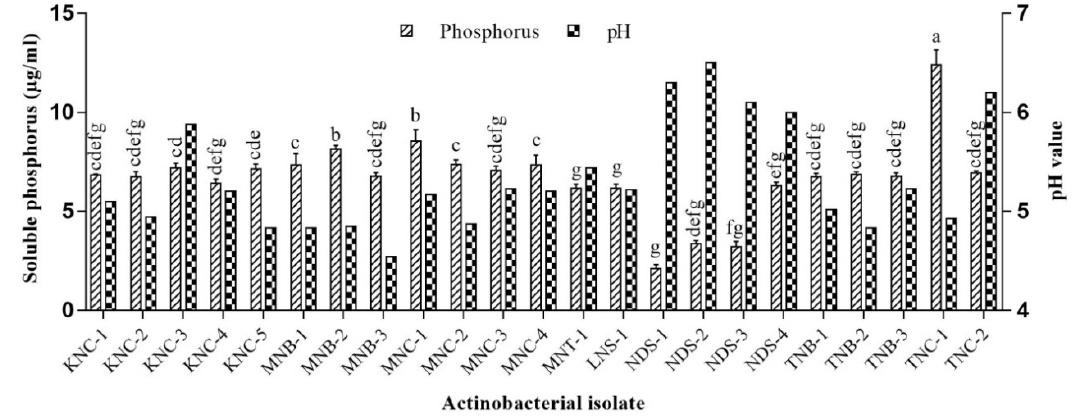
Figure 2. Determination of P solubilization and the evolution of pH in the culture supernatant of actinobacterial isolates. Means ( ± standard deviations) with in the same graphic followed by di ff erent letters are significantly di ff erent at p <